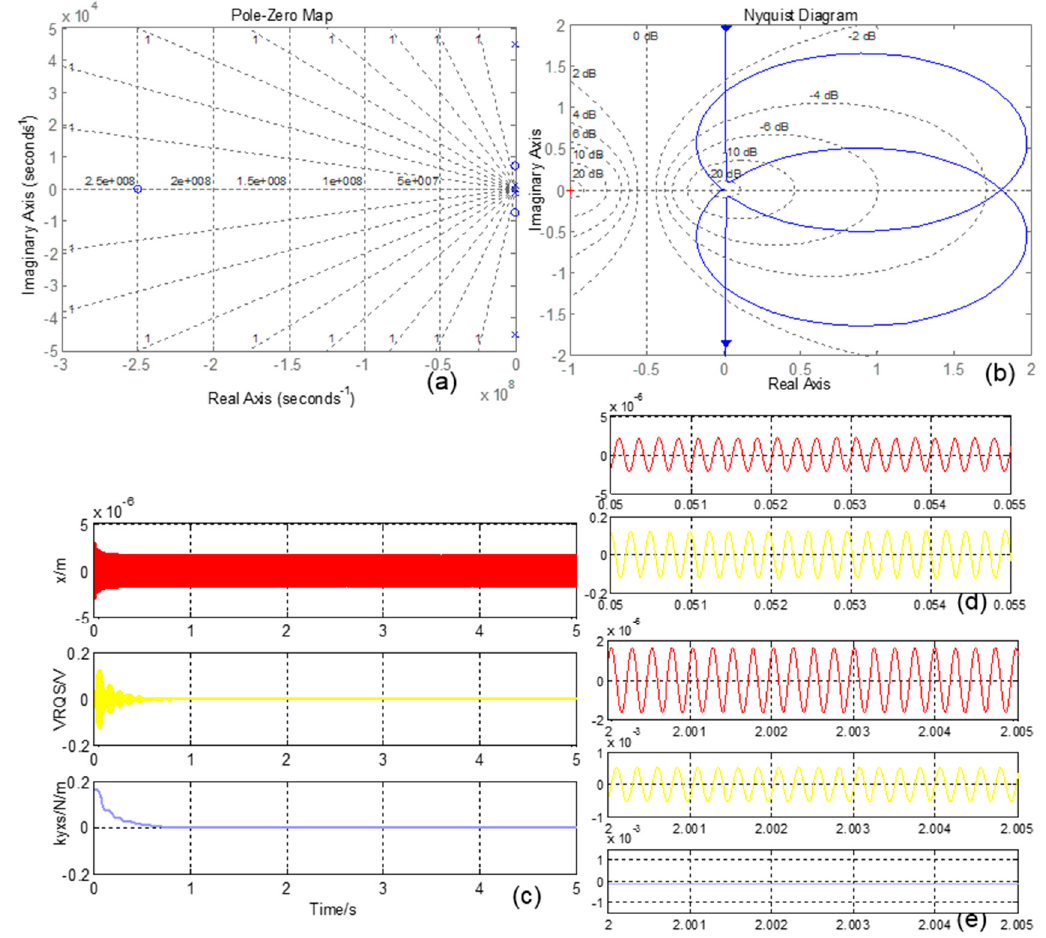
Figure 12. ( a ) CSC system Pole-Zero map; ( b ) CSC system Nyquist Diagram; ( c ) CSC system simulation curves; ( d ) CSC system start-up stage enlarged curves; ( e ) CSF system stable stage enlarged curves.